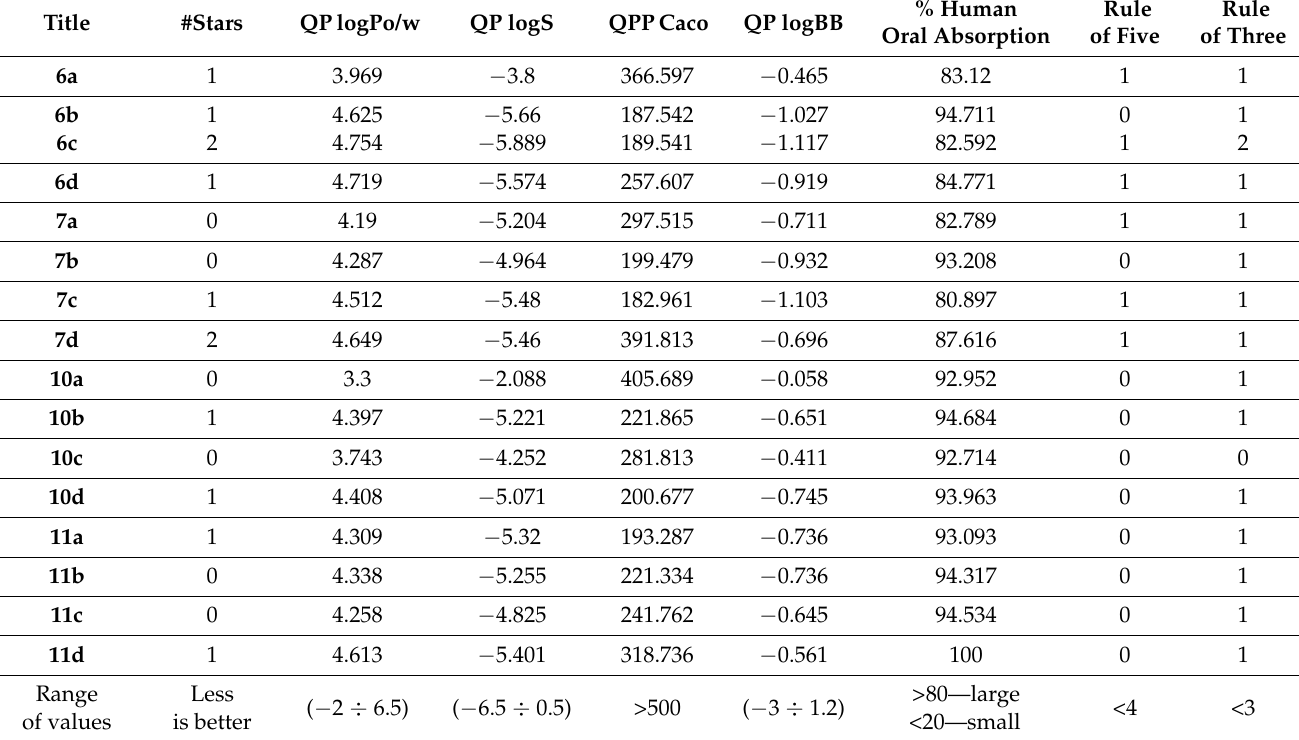
Table 2. Calculated pharmacokinetic (ADME/Tox) parameters of synthesized